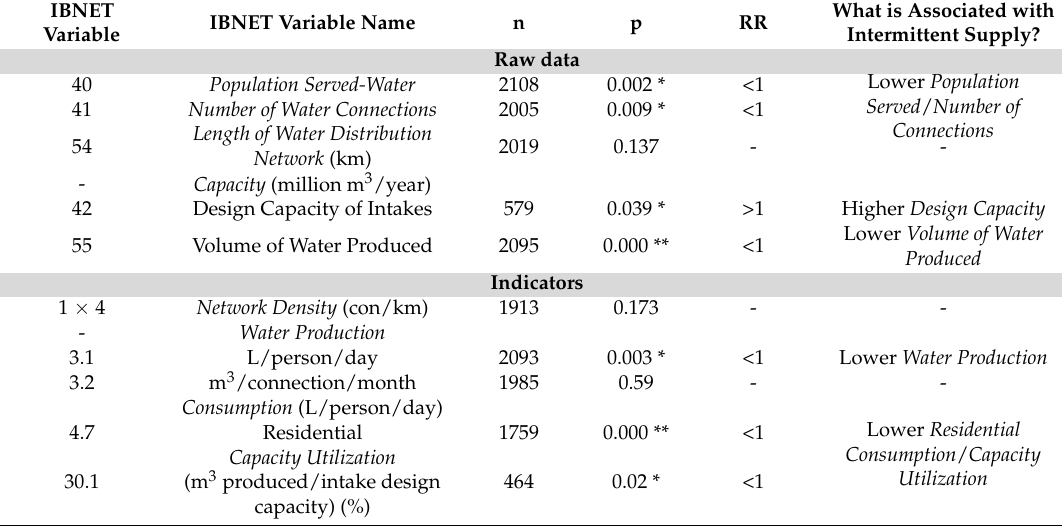
Table 2. A selection of variables related to physical infrastructure system and their relationship to intermittent (<24 h) vs. continuous (24 h) supply. Includes variable number and names as used in the International Benchmarking Network (IBNET) database (ib-net.org), number of observations (n), the p value (p), the relative risk ratio (RR), and an interpretation of the